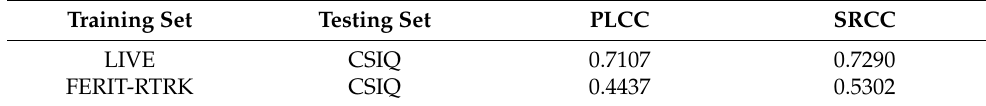
Table 4. Cross-database